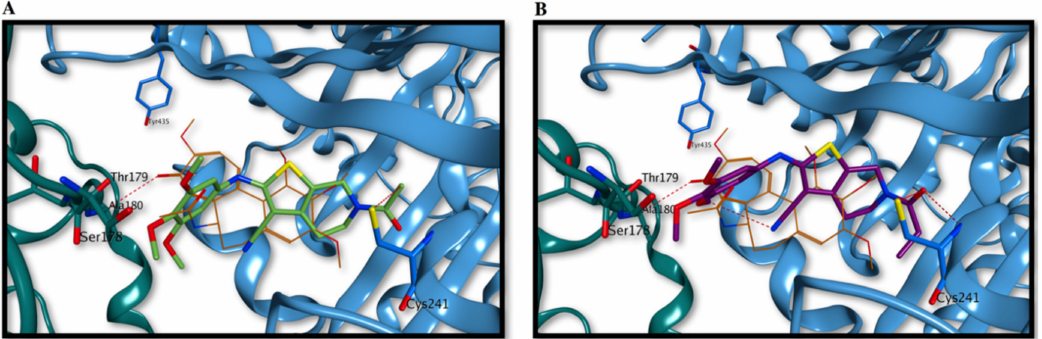
Figure 4. Proposed binding modes for compounds 3a ( A ) and 3b ( B ) in the colchicine site. The trimethoxyphenyl ring is oriented towards the α -tubulin subunit, while the N -methoxy / ethoxycarbonyl moiety at the 6-position of the tetrahydrothieno[2,3- c ]pyridine ring is placed in proximity of β Cys241. Co-crystallized colchicine is shown in orange. The tubulin α subunit is shown as a dark green ribbon, while the β subunit is represented as a cornflower blue